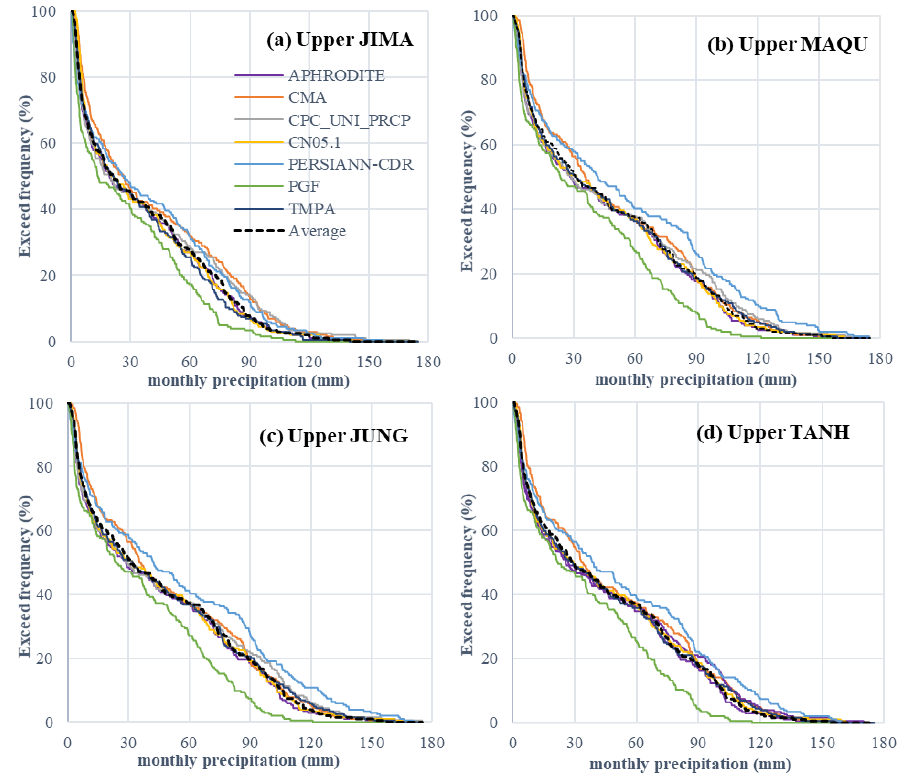
Figure 5. Exceed frequency curves of monthly basin-averaged precipitation upper ( a ) JIMA, ( b ) MAQU, ( c ) JUNG, and ( d ) TANH hydrometric station, where the average series are calculated based on CMA and other 6 precipitation products.